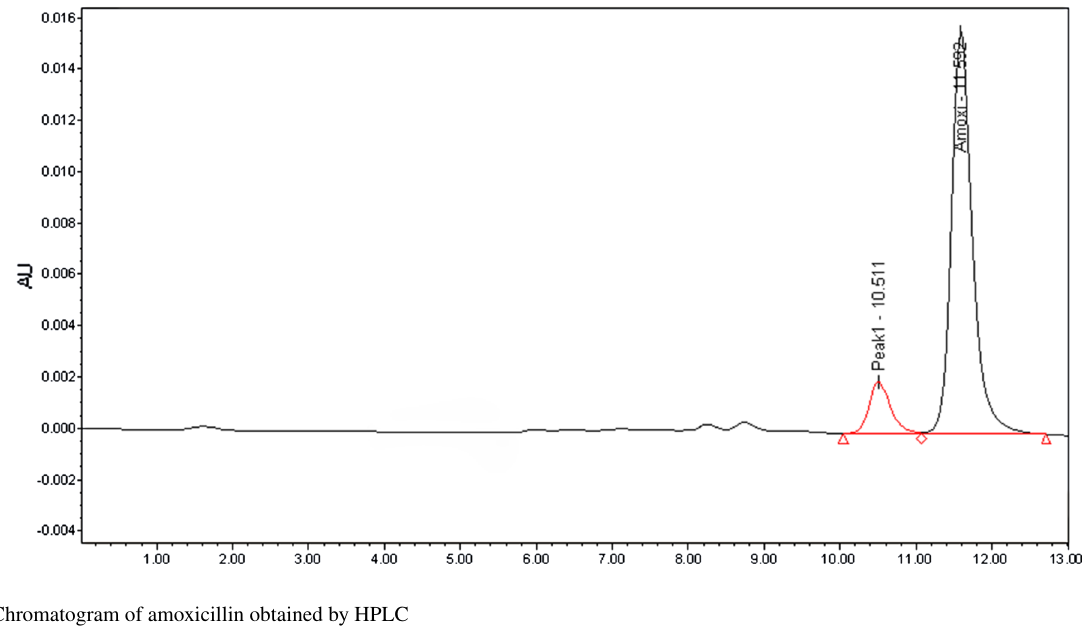
Fig. 2 Chromatogram of amoxicillin obtained by HPLC